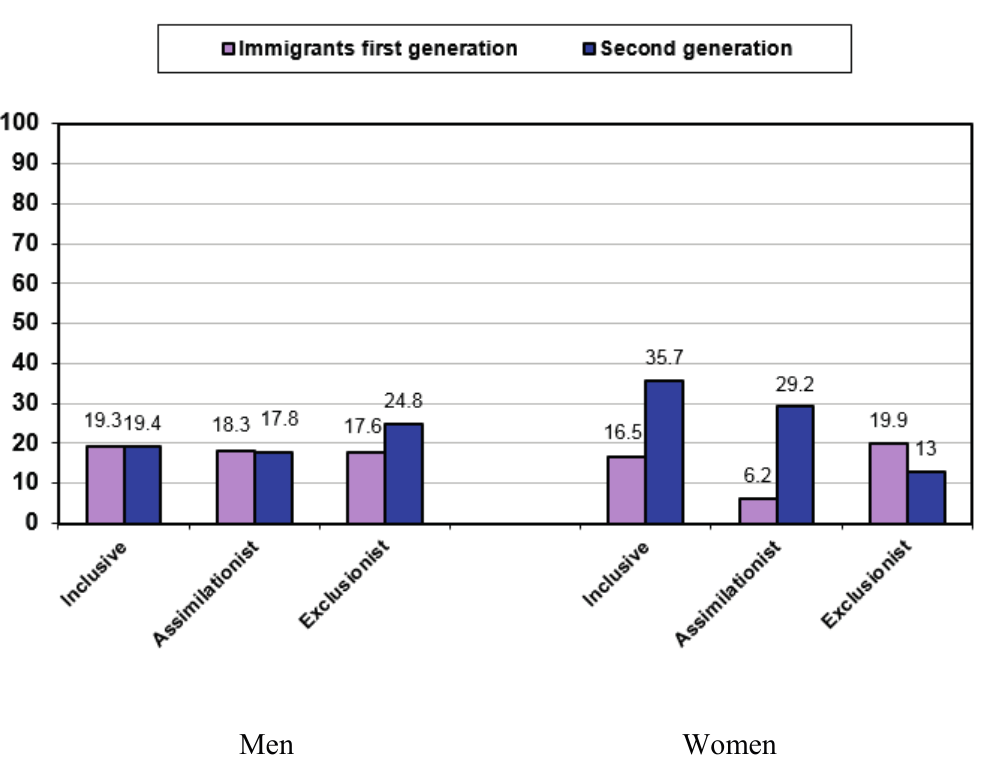
Figure 1. Prevalence of perceived group discrimination among first and second generation immigrants, according to sex and national immigrant integration